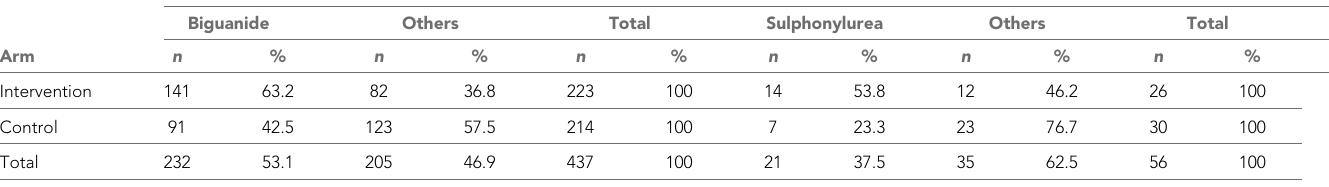
Table 1. Prescriptions for diabetes